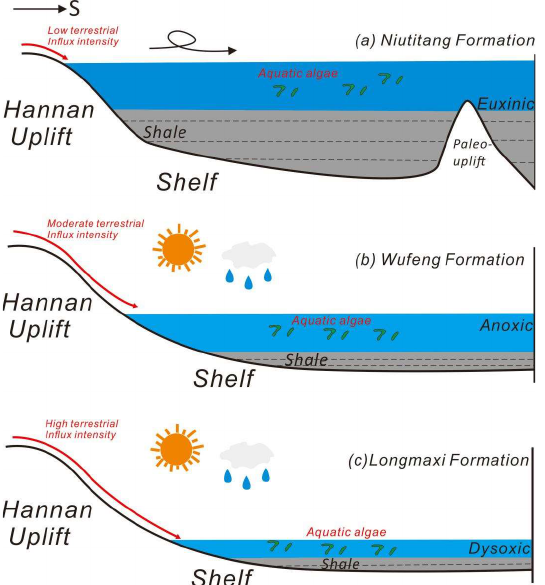
Figure 11. Organic matter enrichment model of shale from the Niutitang Formation ( a ), Wufeng Formation ( b ) and Longmaxi Formation ( c ).